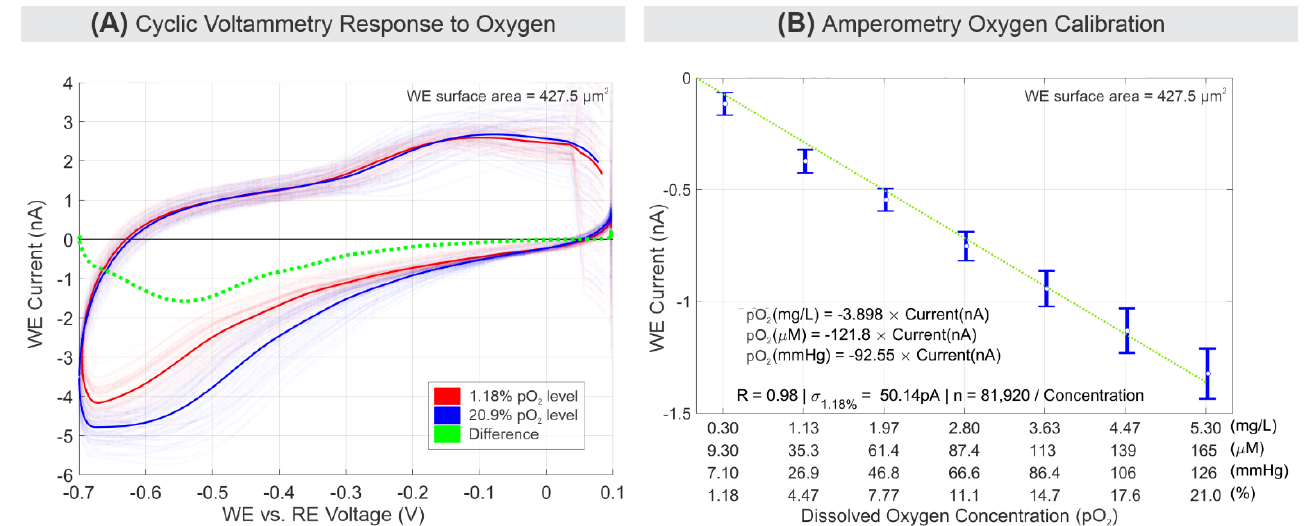
Figure 4. Electrochemical oxygen response. ( A ) Cyclic voltammetry comparison between media with 1.18% to 20.95% pO 2 at 10 V/s scan rate over 64 selected WEs. Resulting readings from every 64 channels are plotted as overlapping opaque curves, and their average is plotted as a solid curve. ( B ) Amperometry sensitivity response of oxygen in media for 1.18% to 20.95% pO 2 . The error bar signifies 1- σ values around the mean.